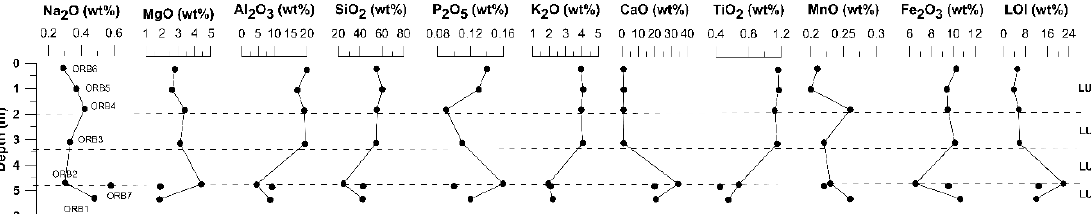
10 of 25 Table 1. Mineralogical composition for the studied samples. Sample